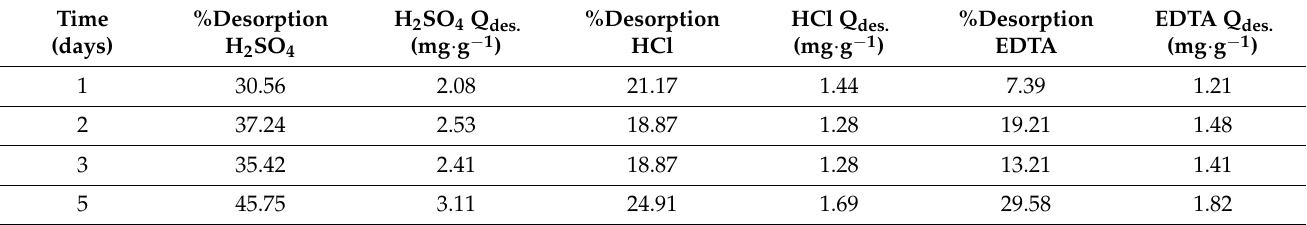
Table 3. Percentage desorption of Cr(VI) and Q des . with different extractant